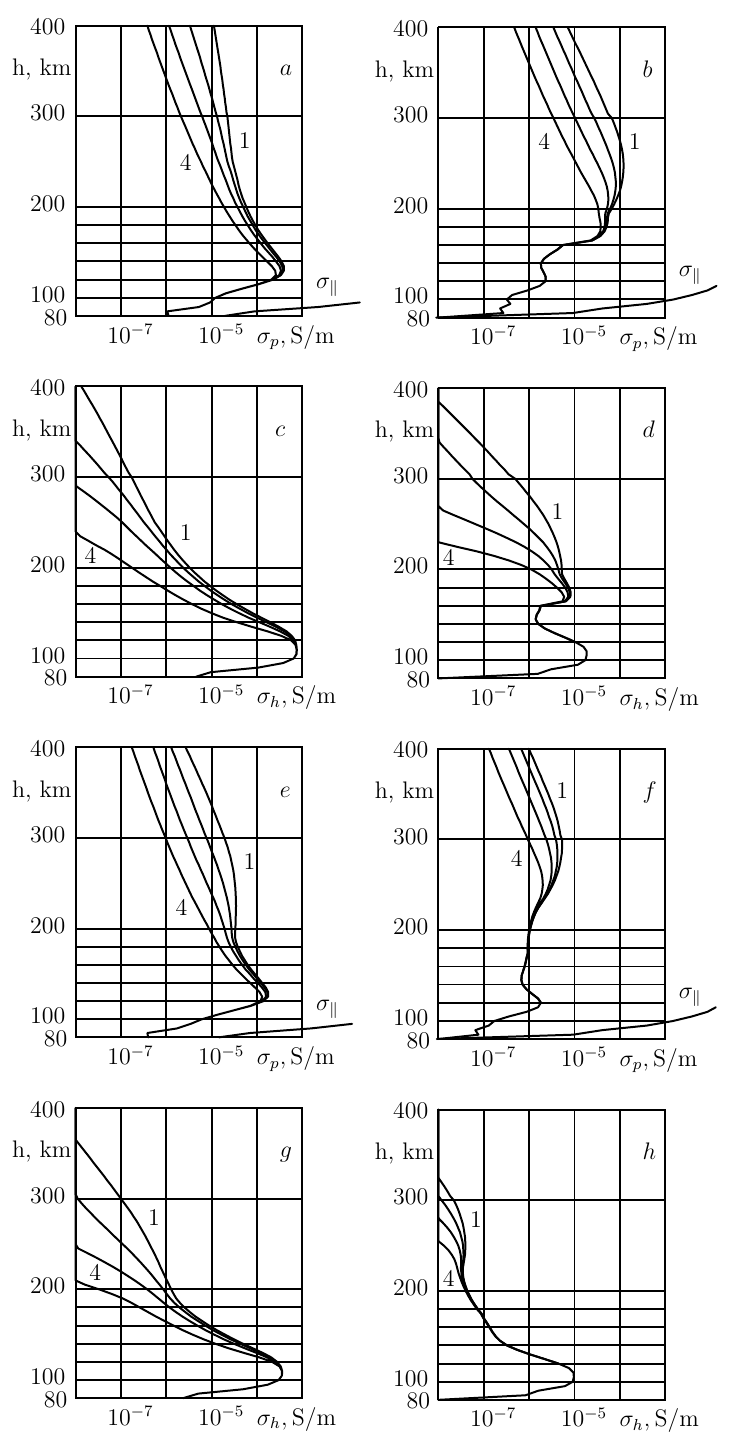
Fig. 2. Height distributions of σ P ,σ H (curves 1), and effective conductivities <σ P > , <σ H > for t 0 = 1 / 3 , 1 , 3h (curves 2, 3, 4). The conditions are the same as for Fig. 1. The panels (a) , (b) , (c) , (d) correspond to θ m = 90 ◦ , (e) , (f) , (g) , (h) correspond to θ m = 45 ◦ . The left and right columns present midday and midnight values, respectively. Height distributions of σ k are partially plotted at the same panels as σ P .